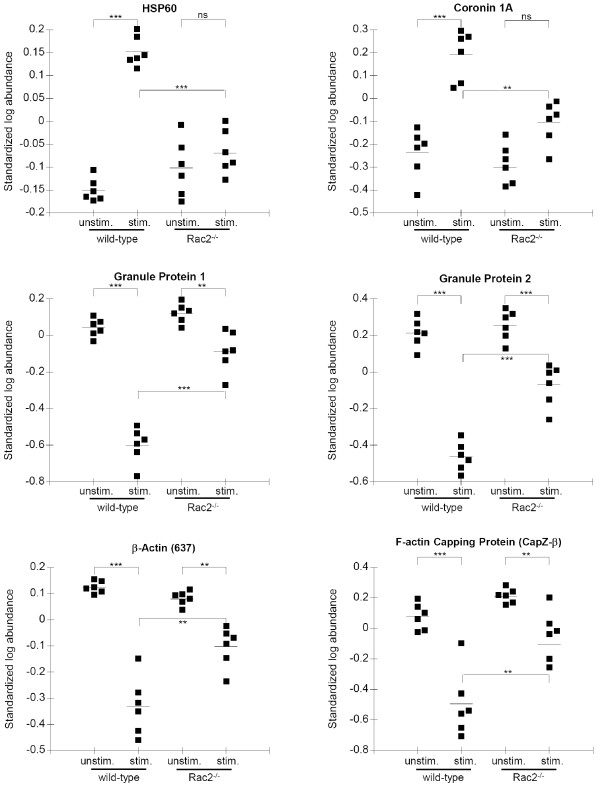
Scatter plots of standardized log abundance of identified proteins. Abundance of spots was determined from fluorescently labelled samples of BMN run on 2D gels. Standardization of spots was to a pooled sample run on all six gels. The statistical significance is shown for paired comparisons (n = 6 for each condition). **, p < 0.01; ***, p < 0.001; ns, p > 0.05 (not significant).